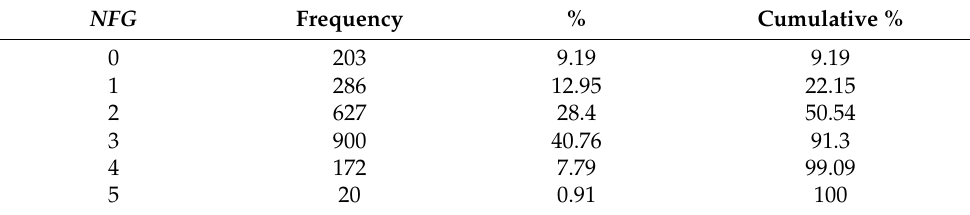
Table 5. Distribution of full known generations ( NFG ) in the reference population (2010–2018).